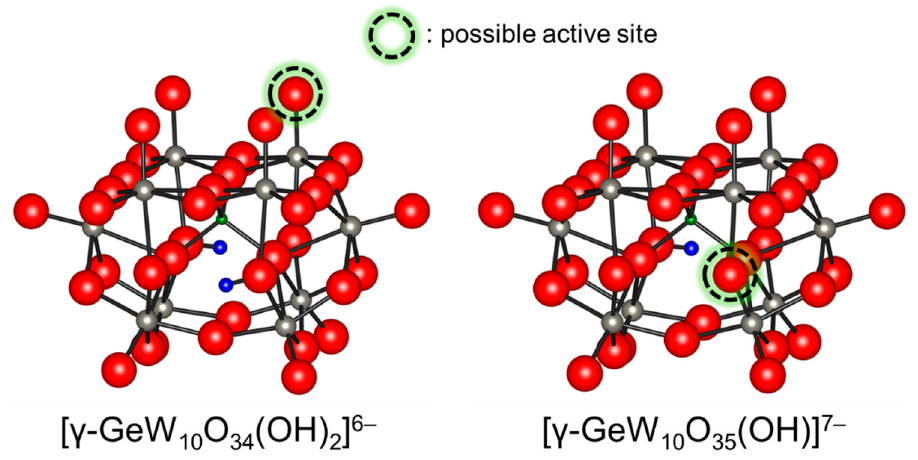
Figure 6. Ball and stick representations of [ γ -GeW 10 O 34 (OH) 2 ] 6 − and [ γ -GeW 10 O 35 (OH)] 7 − and possible active sites for base-catalyzed reactions [46].